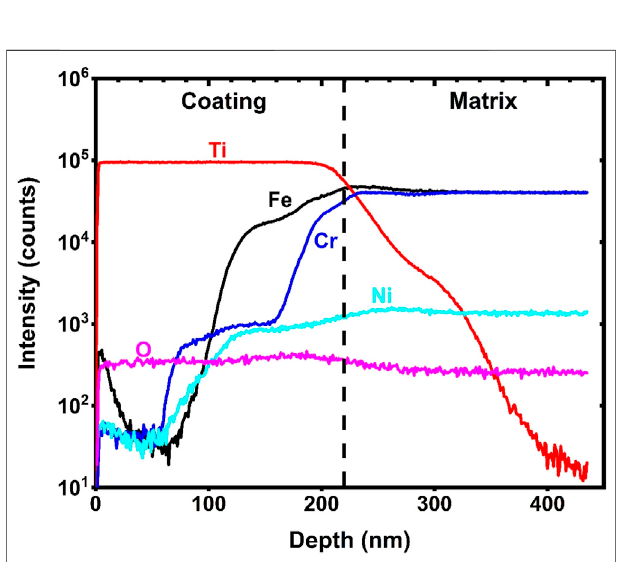
FIGURE 5 | SEM image and EDX analyses results of the three-layer TiO 2 coating on the 304LSS sample.